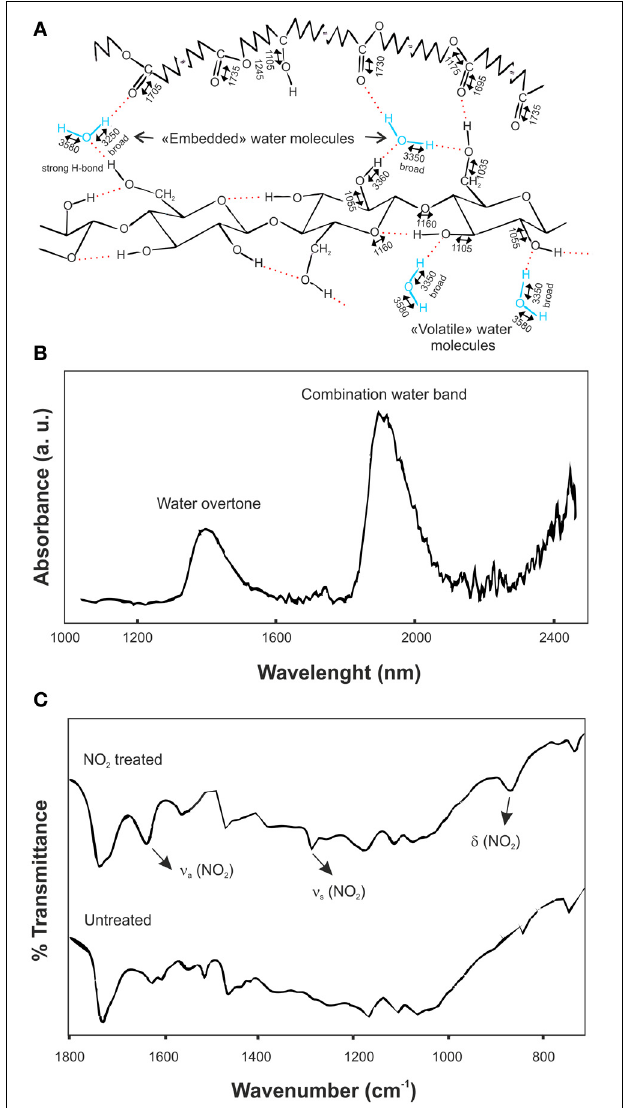
FIGURE 6 | (A) Assignment of vibrational bands in an isolated ivy leaf cuticle. Stretching bands are indicated by two-headed arrows above wavenumbers and are rounded to 5cm − 1 . H 2 O molecules are represented in the “volatile” and “embedded” configurations (adapted from Maréchal and Chamel, 1996, with permission of John Wiley and Sons). (B) Difference NIR reflectance spectrum between Agave americana decutinized plant cuticles at 98 and 30% relative humidity (adapted from Domínguez and Heredia, 1999, with permission of Elsevier). (C) Infrared spectra of NO 2 -treated and untreated isolated tomato fruit cuticular membranes in the 1800-600cm − 1 spectral region (adapted from Luque et al.,